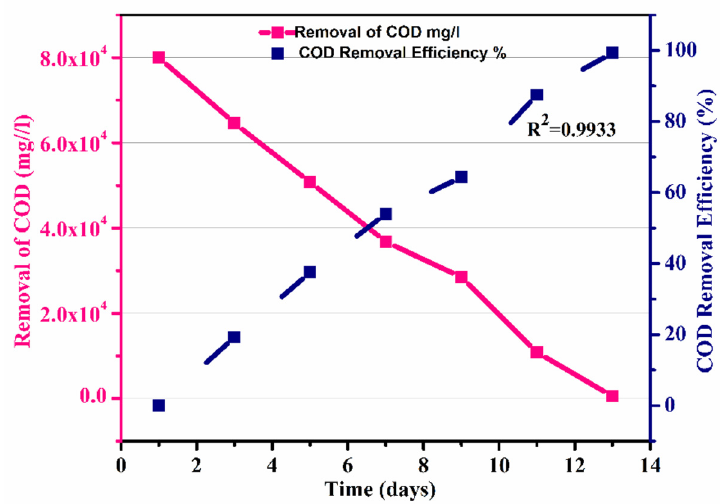
Figure 8. Removal of COD and efficiency of the process over time.